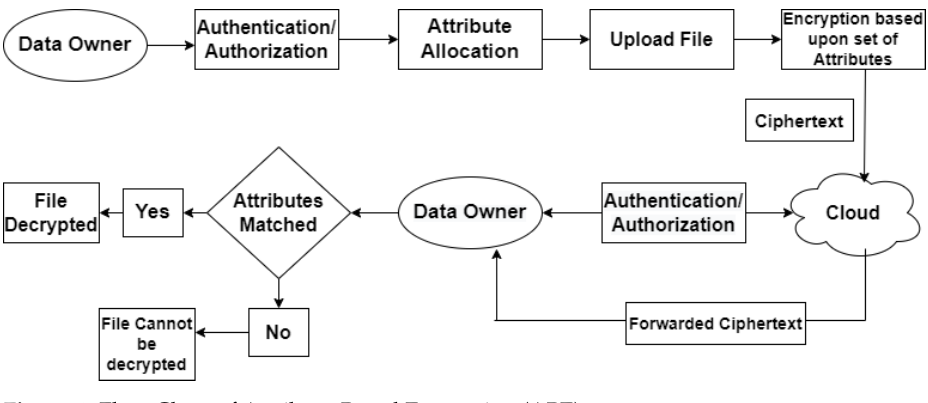
Figure 4. Flow Chart of Attribute-Based Encryption